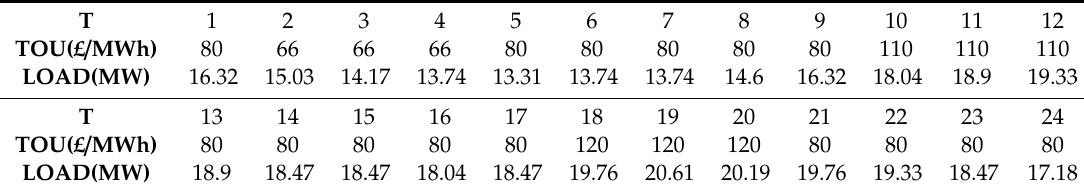
Table 6. TOU price and load data in a